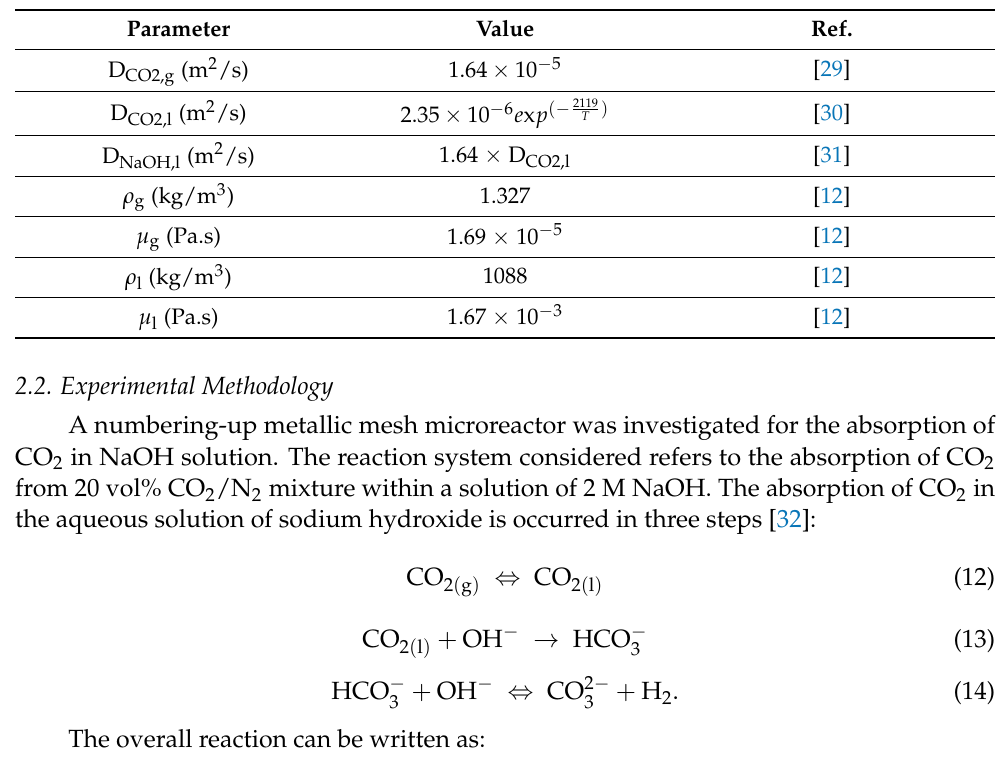
Figure 2. Three ‐ dimensional computational domain of the numbering ‐ up microreactor. Figure 2. Three-dimensional computational domain of the numbering-up microreactor. Table 1. Parameters used for the CFD modelling study. Table 1. Parameters used for the CFD modelling